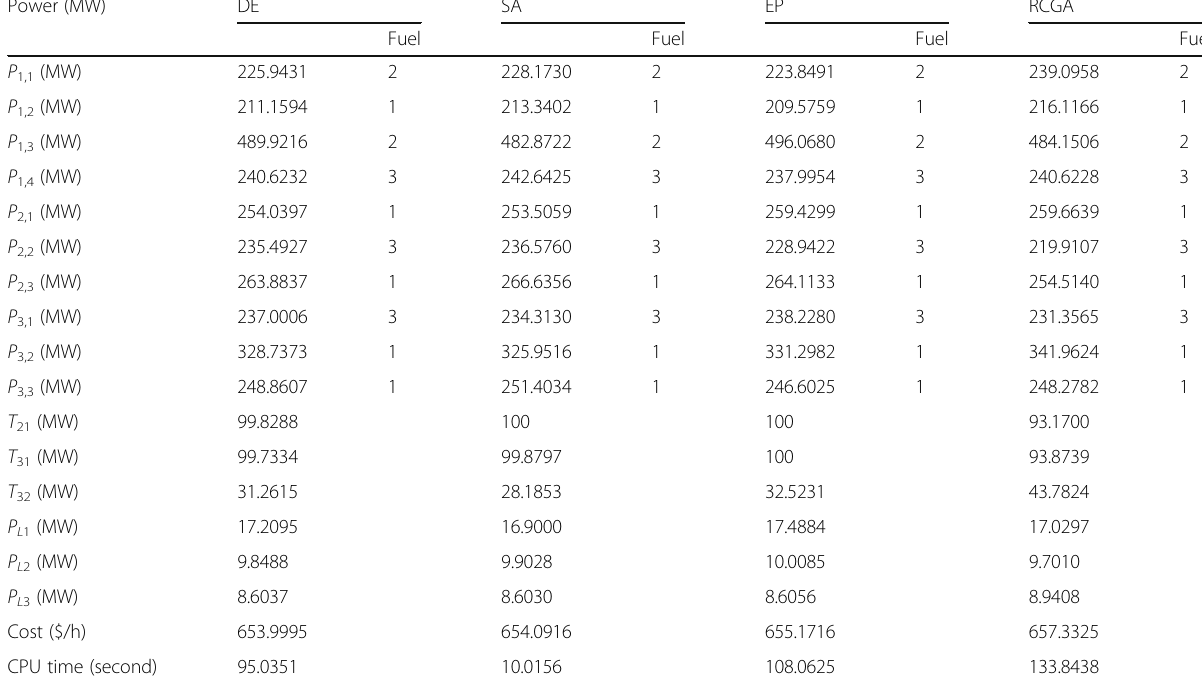
Table 2 Simulation results for test system 2